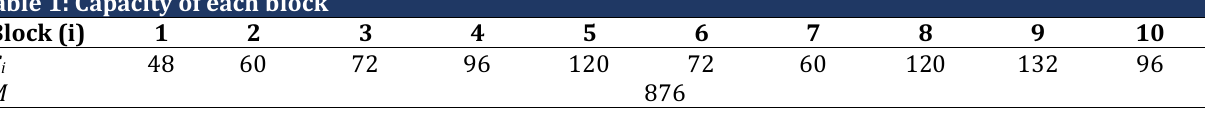
Table 2: Importance coefficients and goals Objective